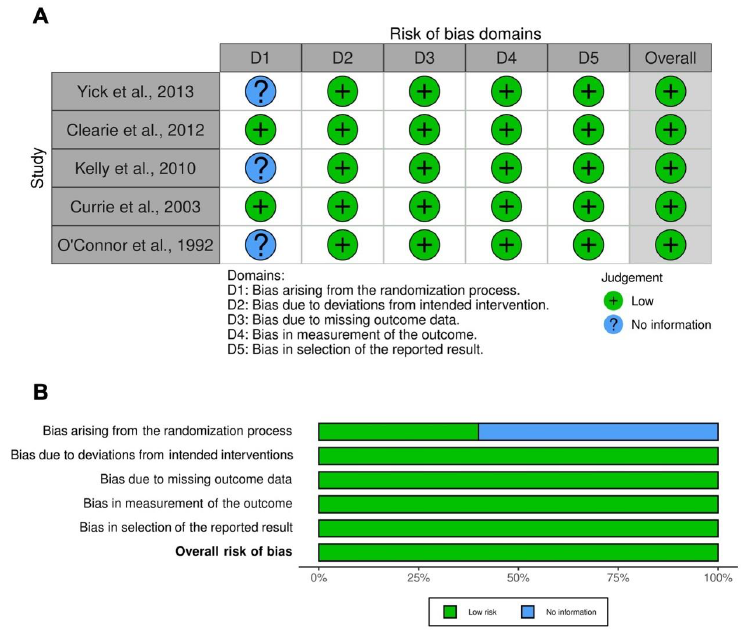
Figure 2. Traffic light plot for the assessment of the risk of bias of each included randomized trial ( A ) and weighted plot for the assessment of the overall risk of bias via the Cochrane RoB 2 tool ( B ) ( n = 5 studies). Traffic light plot reports five risk-of-bias domains: D1, bias arising from the random- ization process; D2, bias due to deviations from the intended intervention; D3, bias due to missing outcome data; D4, bias in measurement of the outcome; and D5, bias in the selection of the reported result; a green circle represents a low risk of bias and a blue circle indicates insufficient information on the risk of bias. RoB: risk of bias.